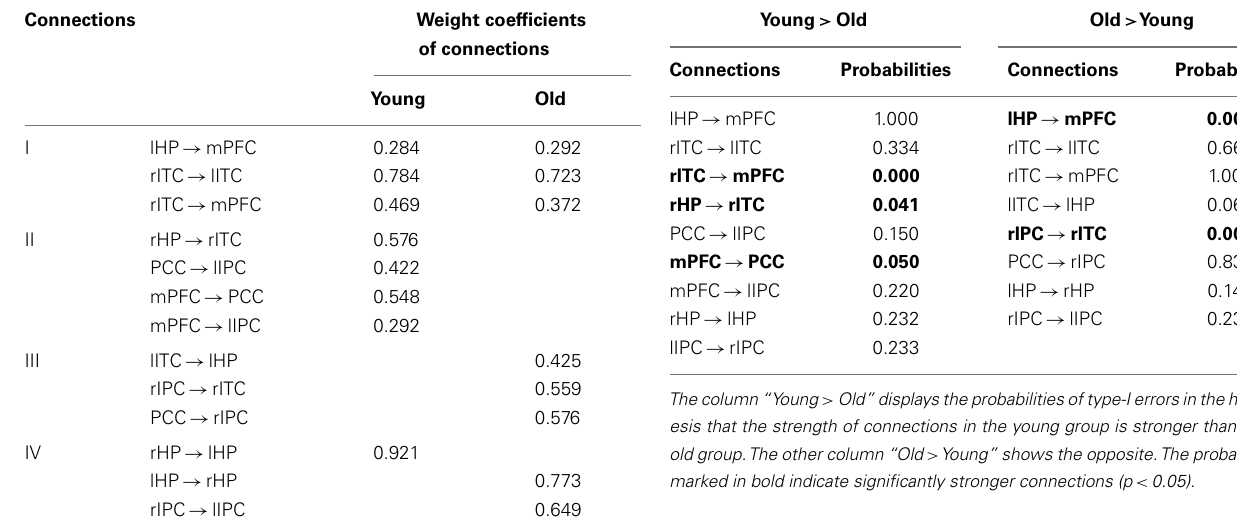
FIGURE 1 | Bayesian network models of the DMN in the young (left panel) and old (right panel) groups .The arrows represent dependencies among brain regions and the thickness of the arrows is